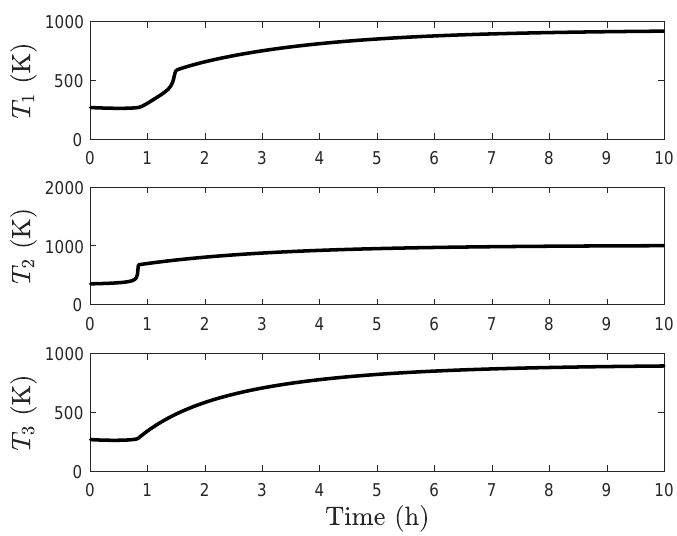
Figure 5. T 1 , T 2 , and T 3 over 10 h of operation for the 2 CSTR-flash drum process under a cyberattacked EMPC provided the false state measurement x F 1 = ¯ x u ,2